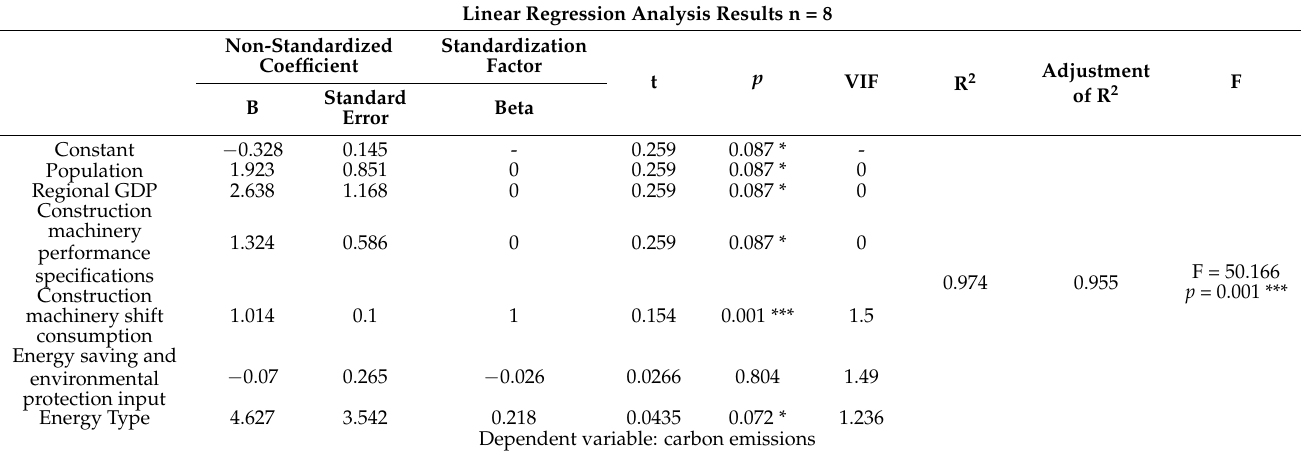
Table 8. Results of the multiple regression analysis of carbon emissions. Linear Regression Analysis Results n = 8